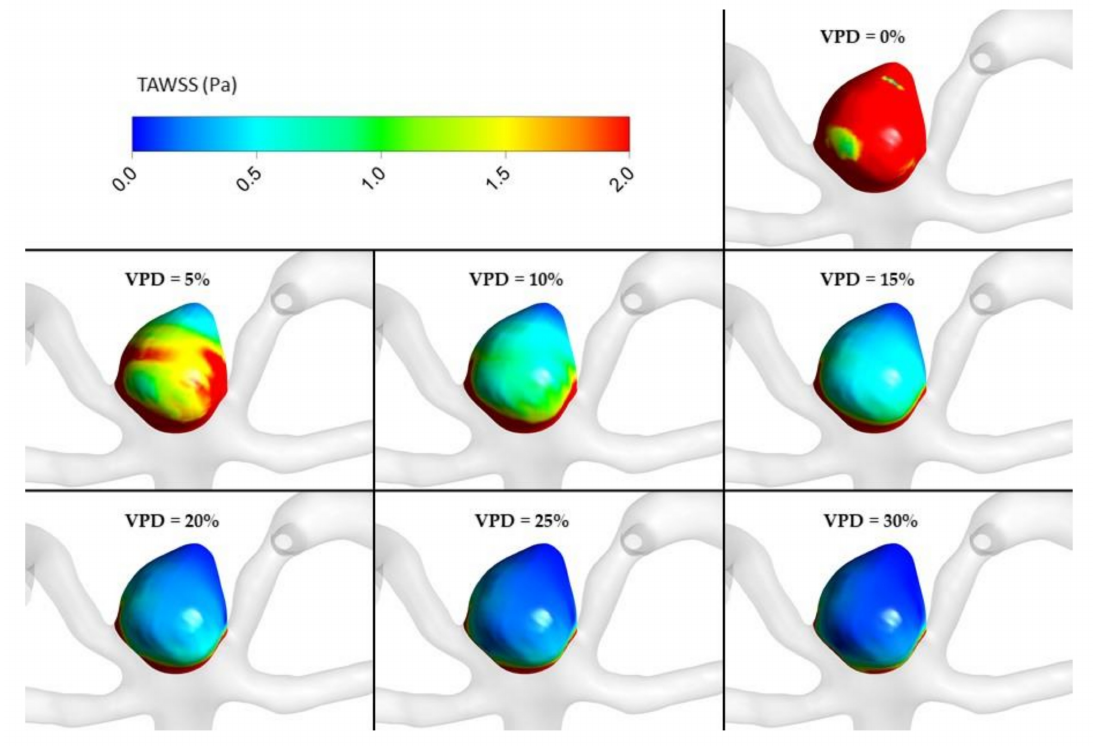
Figure 19. TAWSS distribution at aneurysm wall for selected VPD cases; transient simulations—cycle-averaged